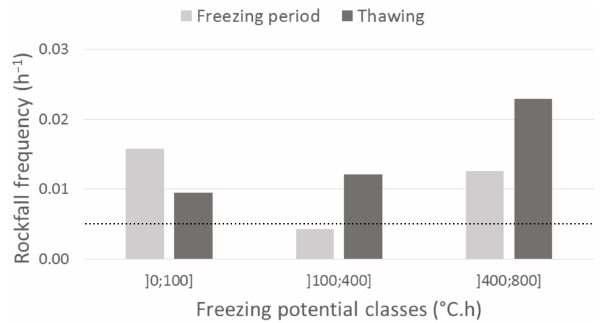
Figure 10. Rockfall frequency according to the freezing potential for freezing periods and thawing